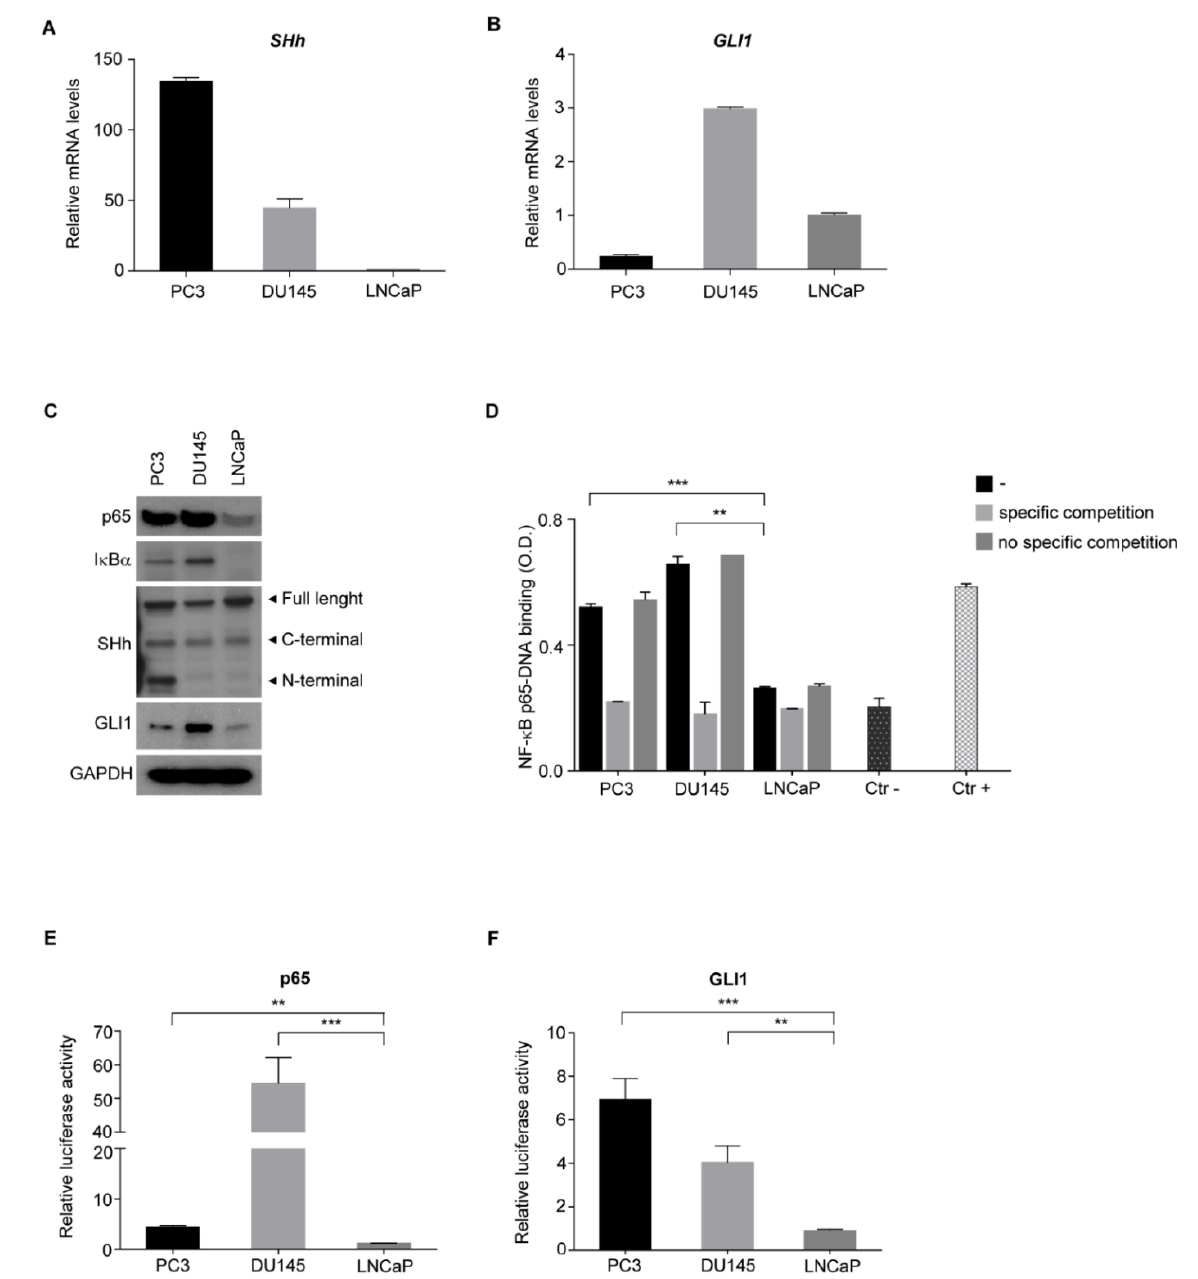
Figure 3. NF- κB promotes the SHh pathway in AI PCa cell lines. ( A , B ) Real-time PCR showing basal level of SHh ( A ) and GLI1 ( B ) in AI (PC3, DU145) and AD (LNCaP) cell lines. ( C ) Western blots showing the basal level of p65, I κ B α , SHh and GLI1 proteins in AI and AD cell lines. GAPDH is shown as the loading control. ( D ) TransAM assay in AI (PC3, DU145) and AD (LNCaP) cell lines. ( E , F ) Dual luciferase reporter assay for p65 ( E ) and GLI1 ( F ) in AI and AD cell lines used in ( A ). Luciferase activity was normalized to Renilla activity. All experiments were performed in triplicate. Values are shown as mean ± S.D. Unpaired Student t -test or Mann – Whitney U-test were used for statistical analysis. ** p < 0.01; *** p < 0.001.